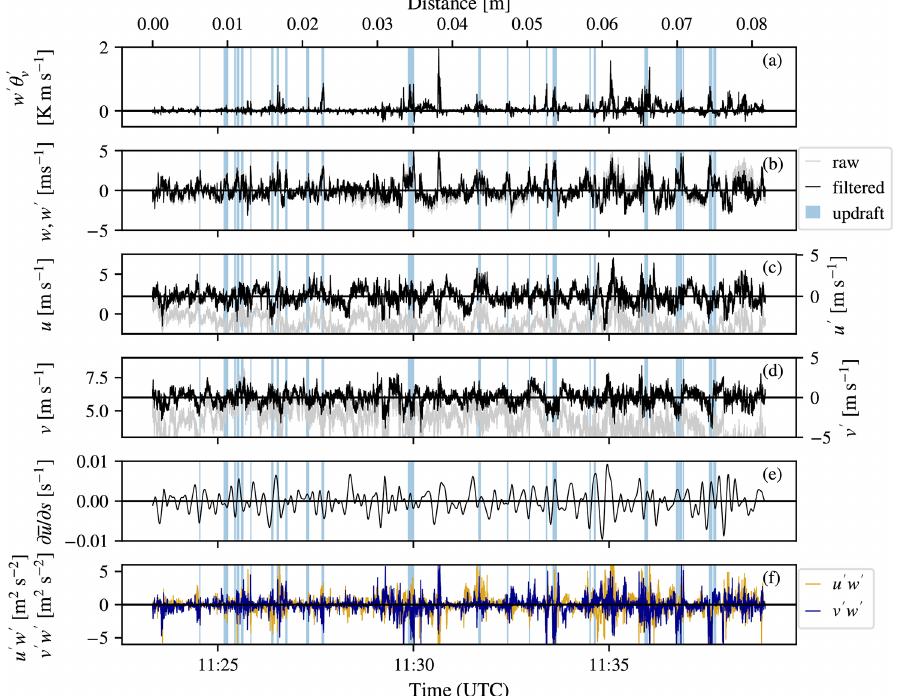
Figure 11. Raw (unfiltered) and fluctuating (filtered: linear detrended, high-pass filter cut-off 0.01Hz) time series of (a) buoyancy flux, (b) vertical velocity, (c) zonal wind, (d) meridional wind, (e) convergence and divergence of the wind speed in the streamwise direction calculated using a low-pass filter that considers all scales larger than 700m ( f c < 0 . 1Hz), and (f) momentum fluxes measured on 4 June 2019 at 600m, in the middle of the mixed layer of the western leg. Updrafts are indicated with light-blue